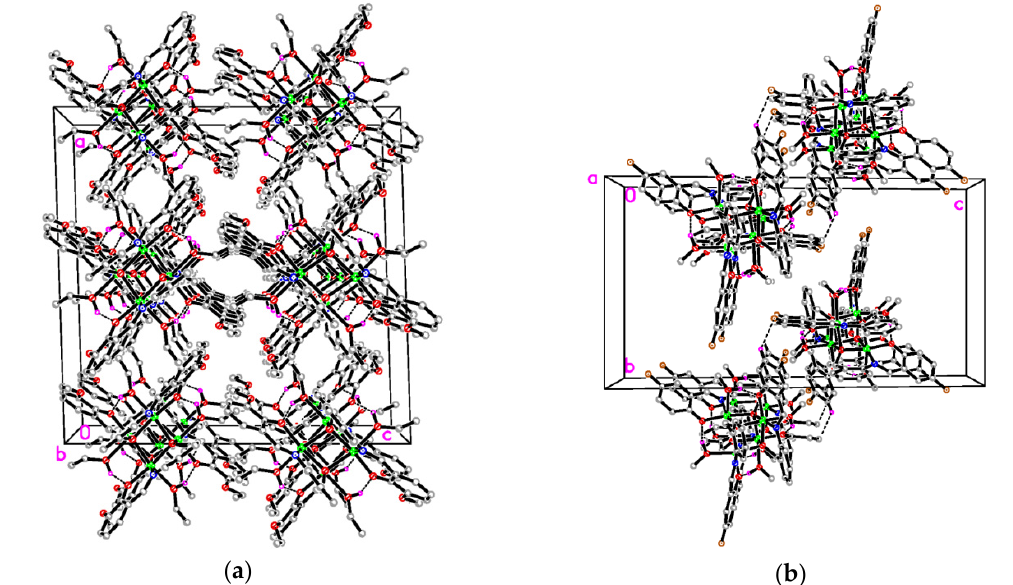
Figure 4. The molecular packing diagram of complex 1 ( a , viewed along the b axis) and 2 ( b , viewed along the a axis). Intramolecular O–H···O hydrogen and intermolecular C–H···F interactions are shown as dashed lines.